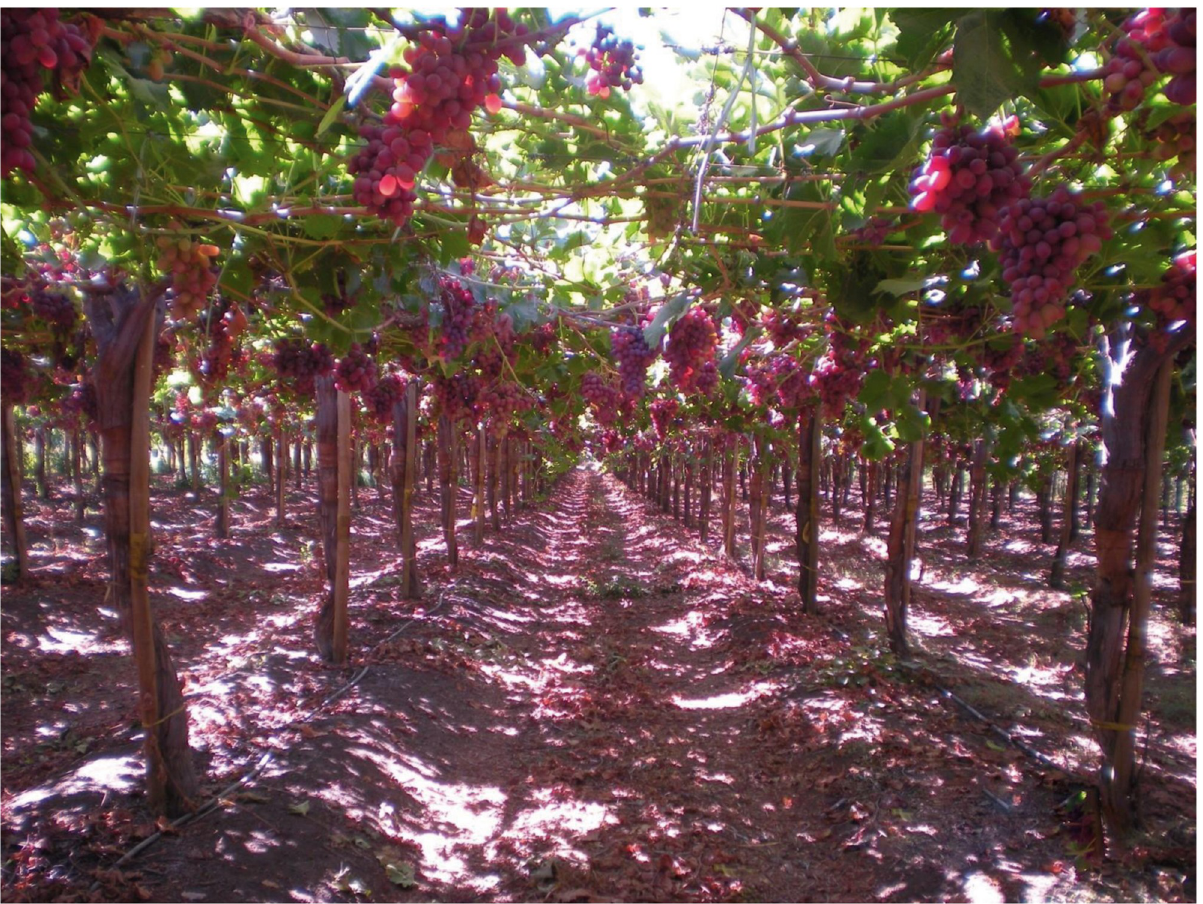
Fig 1. A grape orchard ( Vitis vinifera ) located in Til-Til. The plants are Sultanina